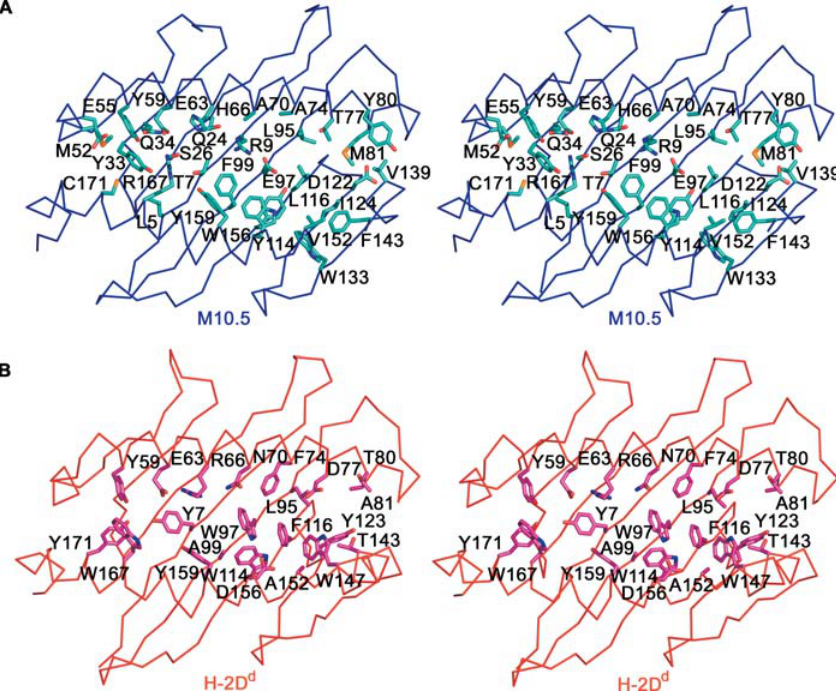
Figure 3. Groove Residues in M10.5 and H-2D d Stereo view of residues lining the a 1– a 2 groove in M10.5 (A) and H-2D d (B). Groove residues are defined as in Table 2. DOI: